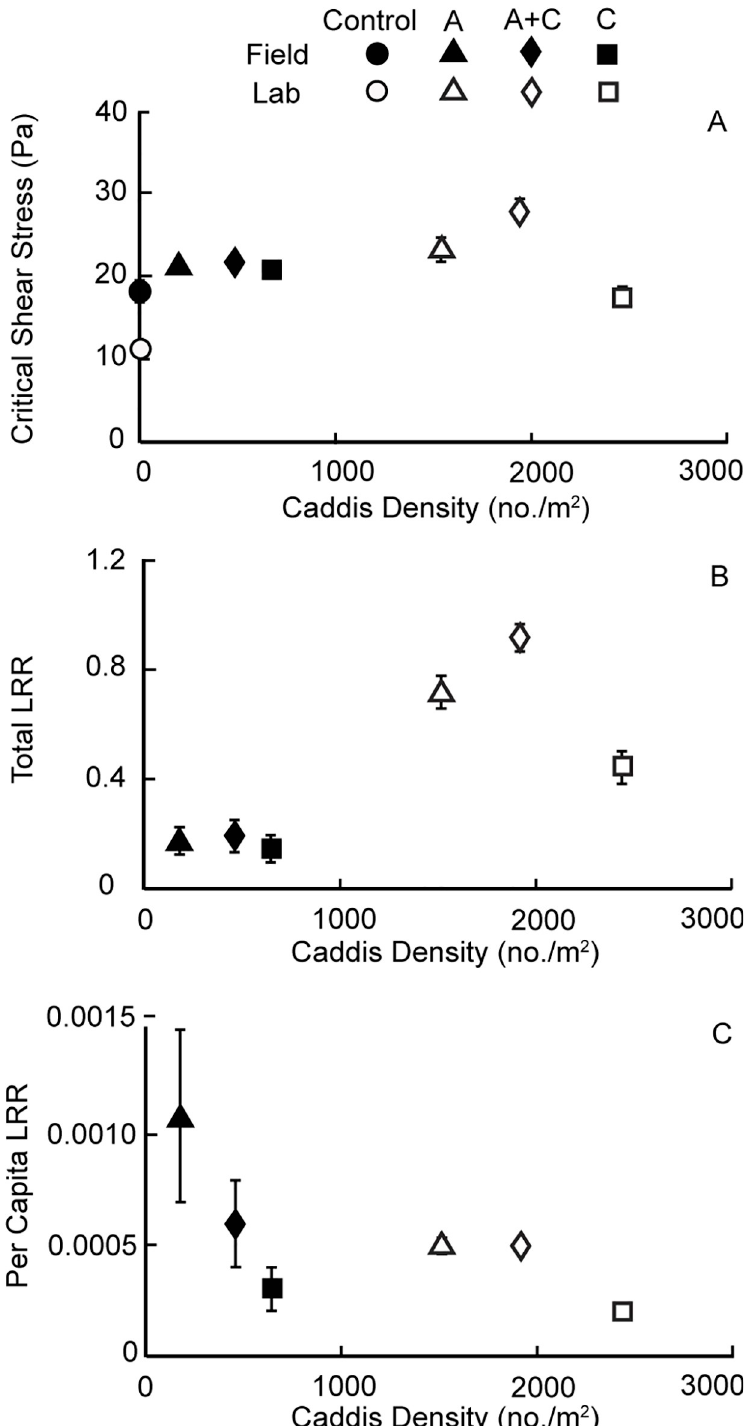
Fig 2. (A) The critical shear stress required to initiate sediment motion (in Pascals ± 1 SEM, equivalent to average force per unit area in Newtons/m 2 ), measured across the average caddisfly densities (no./m 2 ) found in the four experimental treatments in both the semi-natural channels (solid symbols, this study) and a previous laboratory study (open symbols, Albertson et al. 2014a). The figure includes data from control treatments without caddisflies (Control, circles) and experimental treatments containing Arctopsyche californica alone (A, triangles), Ceratopsyche oslari alone (C, squares), and both species together (polyculture, A + C, diamonds). (B) Total log response ratio (LRR)